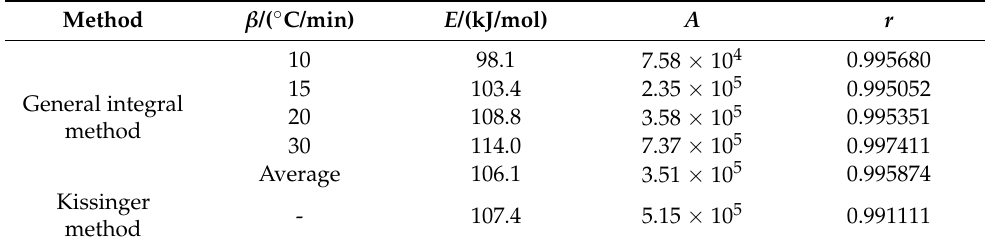
Table 2. Results of the fitting of the reaction kinetics.